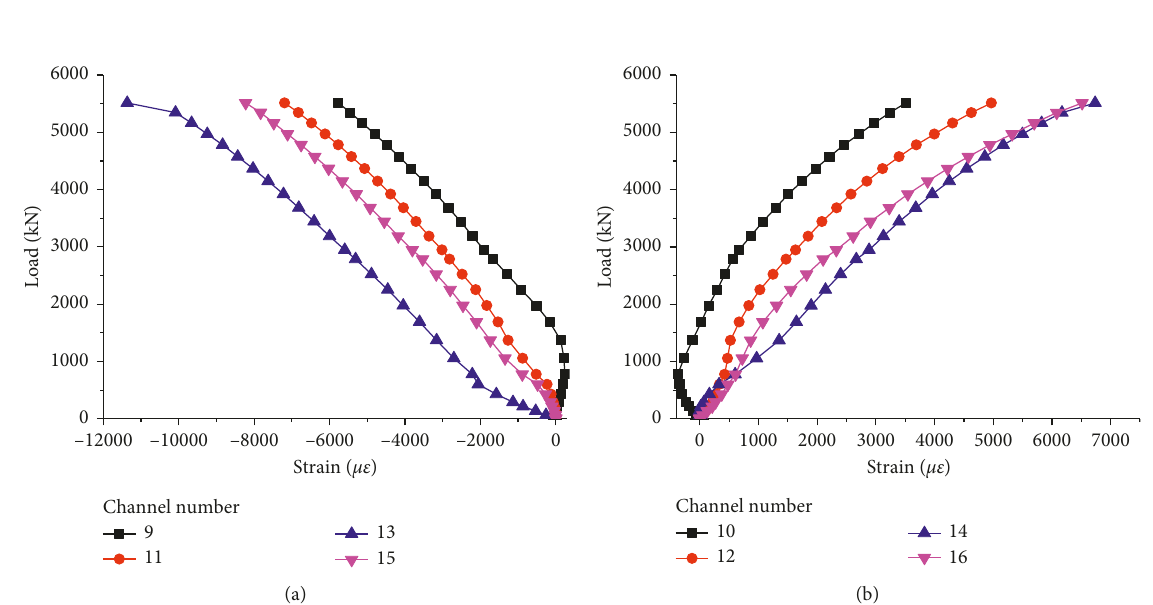
Figure 8: Static strain at the first row of the composite material section of GZ-6: (a) longitudinal load-strain curves; (b) circumferential load- strain